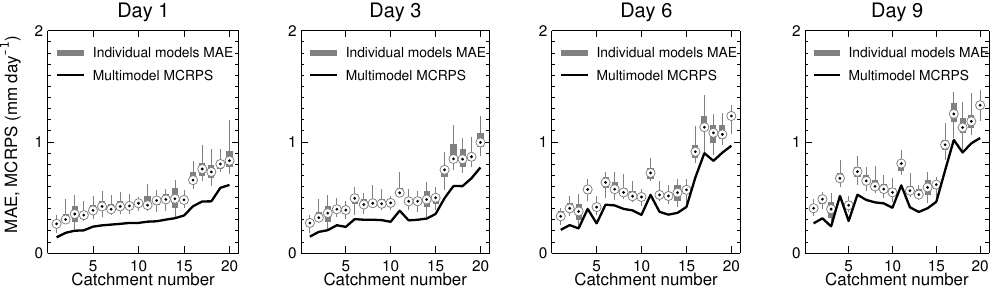
Figure 3. Comparison of individual models MAE and multimodel MCRPS sorted by increasing multimodel MCRPS for the first day (ver- sion A vs. E).